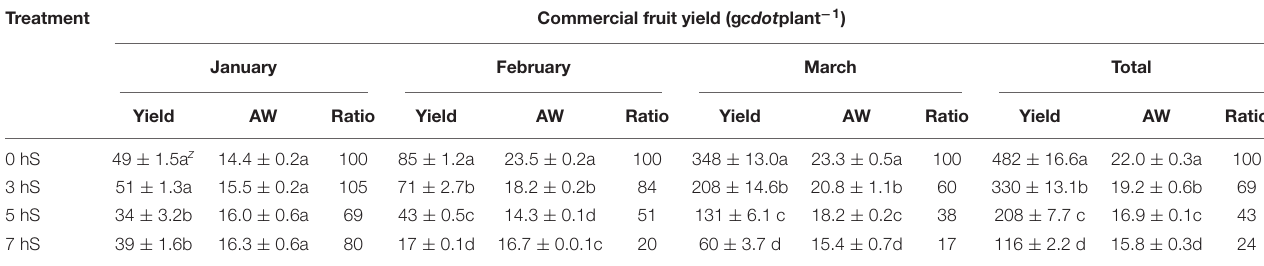
TABLE 1 | Commercial fruit yield of strawberry ( Fragaria × ananassa ) grown under various light intensity conditions in a smart greenhouse. Treatment